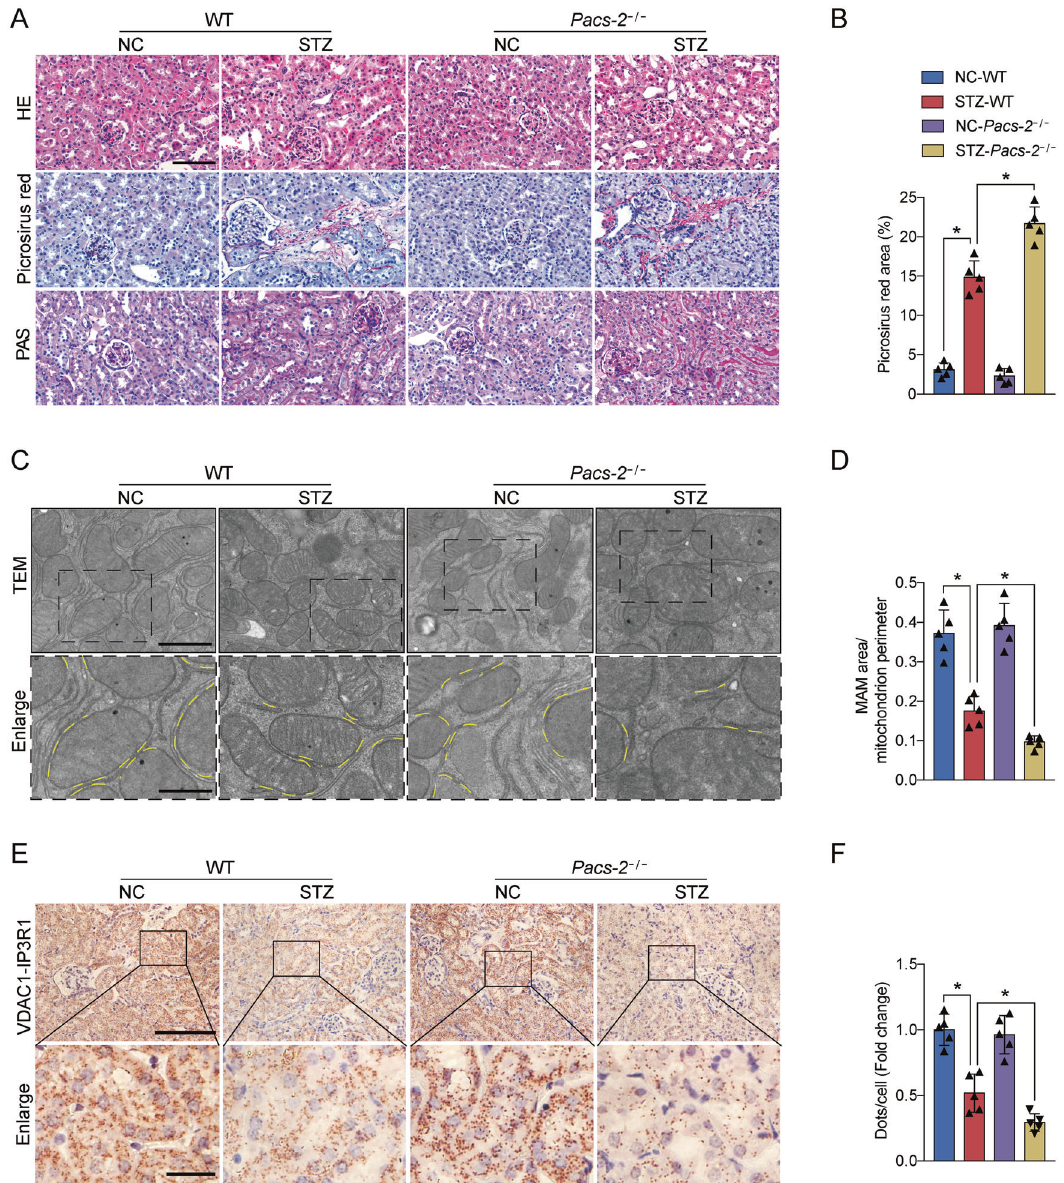
Fig. 2 PACS-2 ablation aggregated histopathological changes and reduced MAM formation in diabetic kidneys. A Representative images of HE, Picrosirius red, and PAS staining of kidney sections. Scale bar = 100 μ m. B Quantitative analysis of Picrosirius red staining in A . n = 5. C Representative TEM images showing the MAM area in the kidneys. Yellow lines indicate the MAM interface. Scale bars = 1 μ m, inset scale bar = 500 nm. D Quantitative analysis of MAM area normalized to mitochondrion perimeter in C . n = 5. E Representative in situ PLA images showing the VDAC1/IP3R1 interactions in the kidneys. Scale bars = 100 μ m, inset scale bar = 20 μ m. F Quantitative analysis of in situ PLA dots in E . n = 5. All data are expressed as mean ± SD. * P <